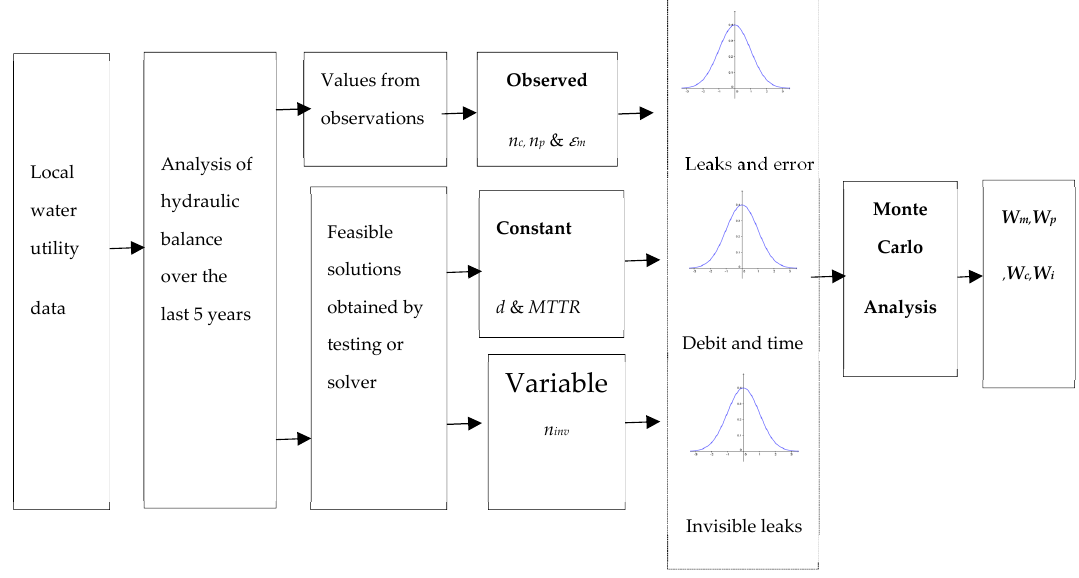
Figure 1. Steps for annual water losses estimation, adapted from Ref. [16].